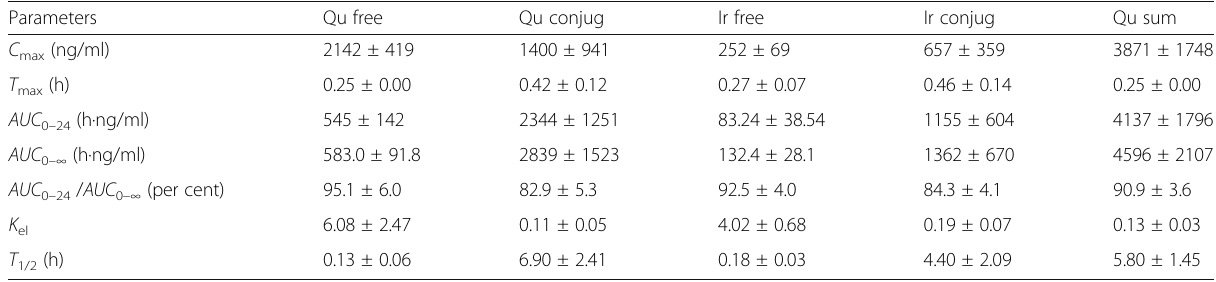
Table 2 Mean pharmacokinetic parameters of Qu in plasma for 12 volunteers after intravenous administration of Corvitin® (average dose of anhydrous Qu was 44